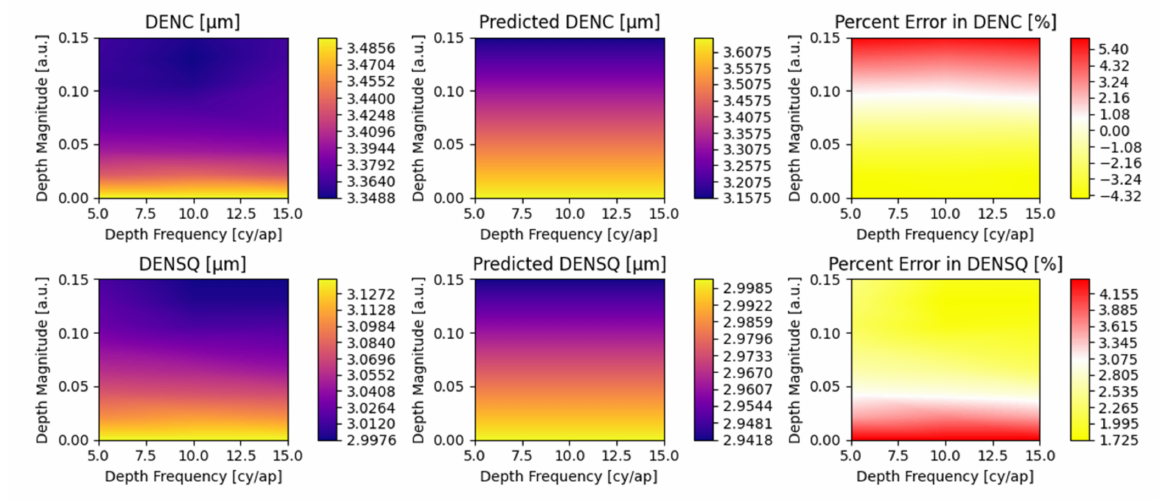
Figure A15. Depth Frequency vs. depth magnitude. ( κ = ω = δ = 0, ξ = 10, σ = 0.05, θ = 30 ◦ ).